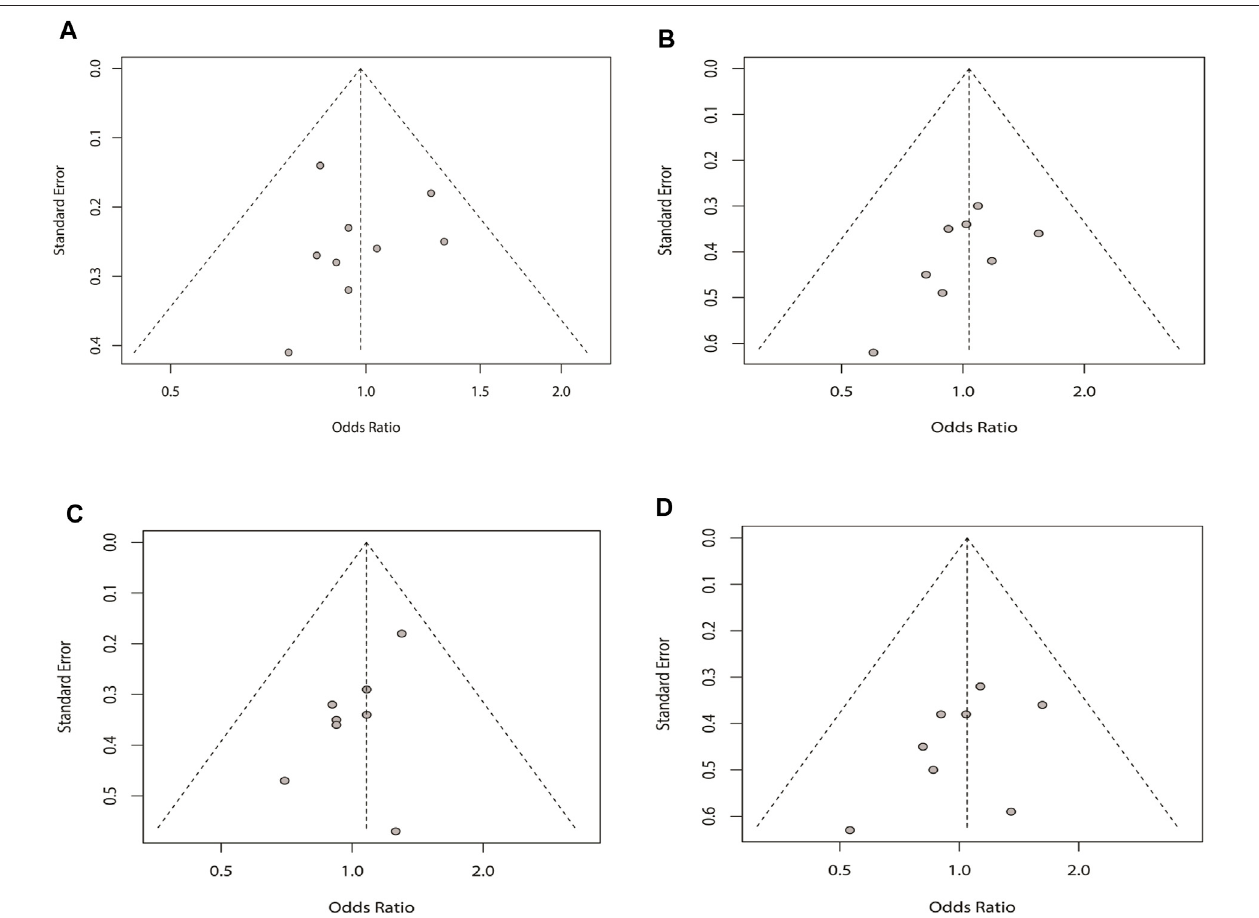
FIGURE 6 | Sensitivity analysis of the four genetic models for rs2200733 and rs6843082 in the pooled population: (A) allele model for the two SNPs in the pooled population, (B) recessivemodelforthetwoSNPsinthepooledpopulation, (C) dominantmodelforthetwoSNPsinthepooledpopulation,and (D) additivemodelforthe two SNPs in the pooled